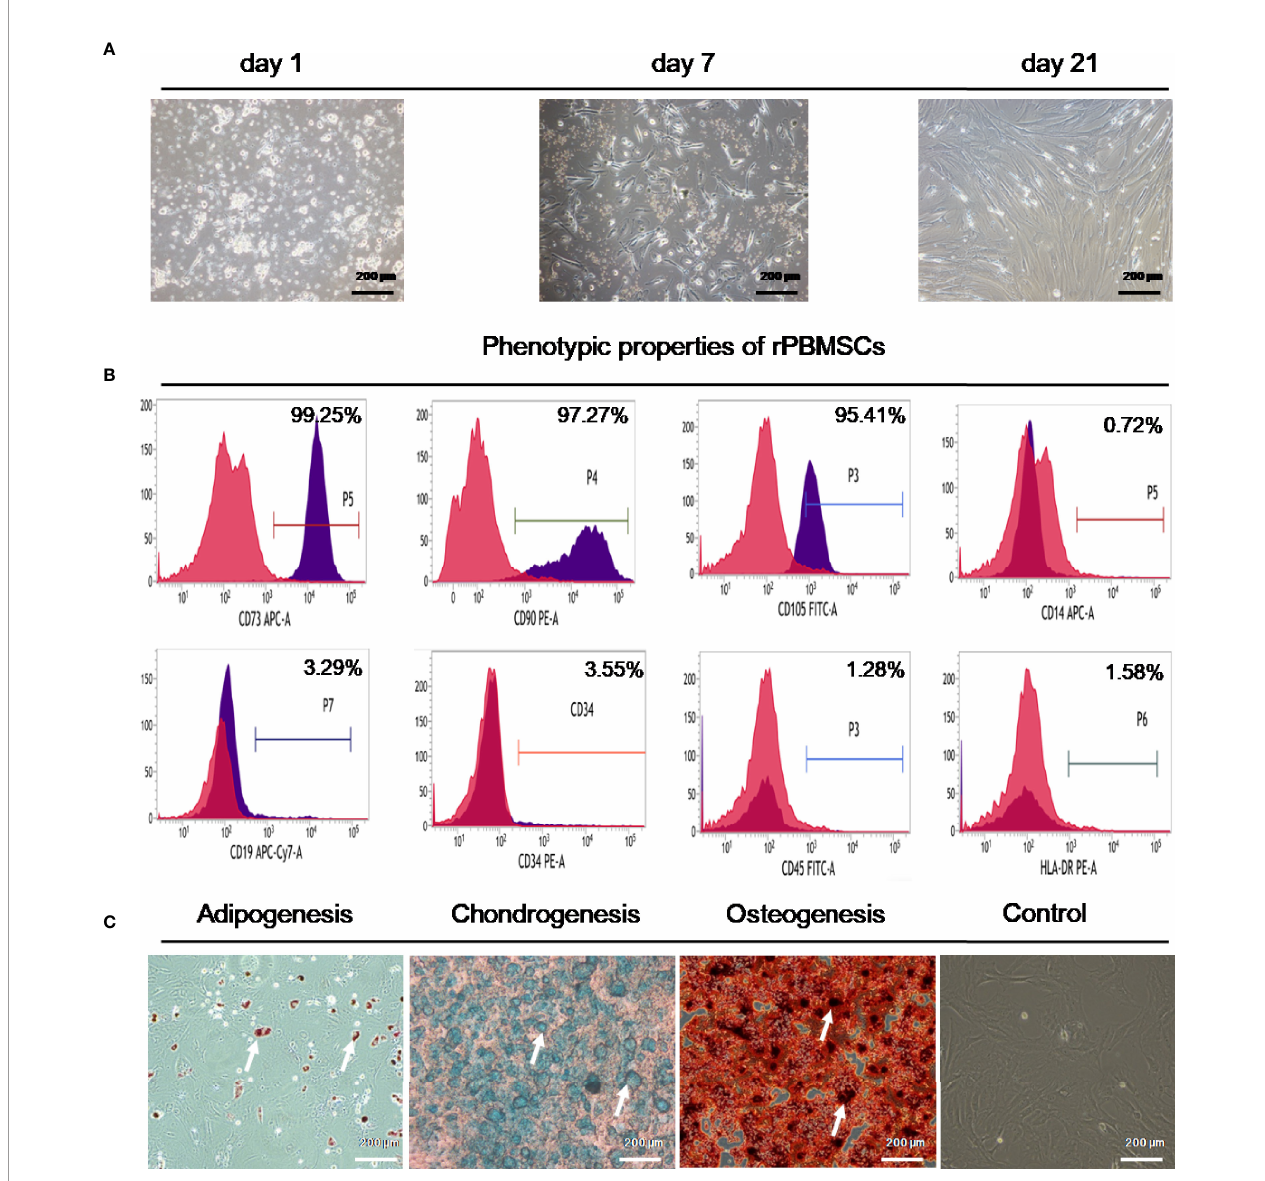
FIGURE 1 | Characteristics of rPBMSCs. (A) Morphology of rPBMSCs cultured for 1 day, 7 days, and 21 days. (B) Immunocytochemical staining demonstrated a positive expression of CD73 , CD90 , and CD105 and negative expressions of CD14, CD19, CD34, CD45 CD45 , and HLA-DR . (C) Multilineage differentiation capacities of rPBMSCs. Magni fi cation, 200×. rPBMSCs, rat peripheral blood-derived mesenchymal stromal